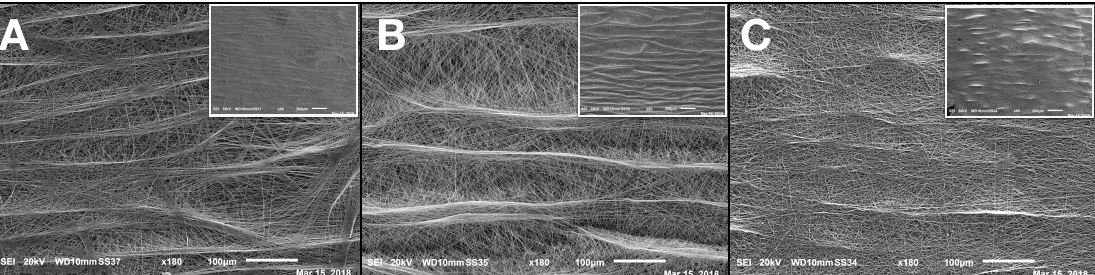
Figure 1. SEM micrographs of the polycaprolactone/polyhydroxybutyrate (PCL/PHB) thin nanomembranes (NMs) after electrospinning deposition and before the incubation with duckweed plants: ( A ) control PCL/PHB nanofibrous scaffolds (CNMs); ( B ) electrospun PCL/PHB NMs loading lower (C 1 ) and ( C ) higher (C 2 ) catechol concentrations (C 1 L-NMs and C 2 L-NMs, respectively) (magnification ×185); insets = top views of the same nanostructures (magnification ×65). Scale bars in the micrographs correspond to 100 µm ( A , B , C ) and to 200 µm (relative insets).